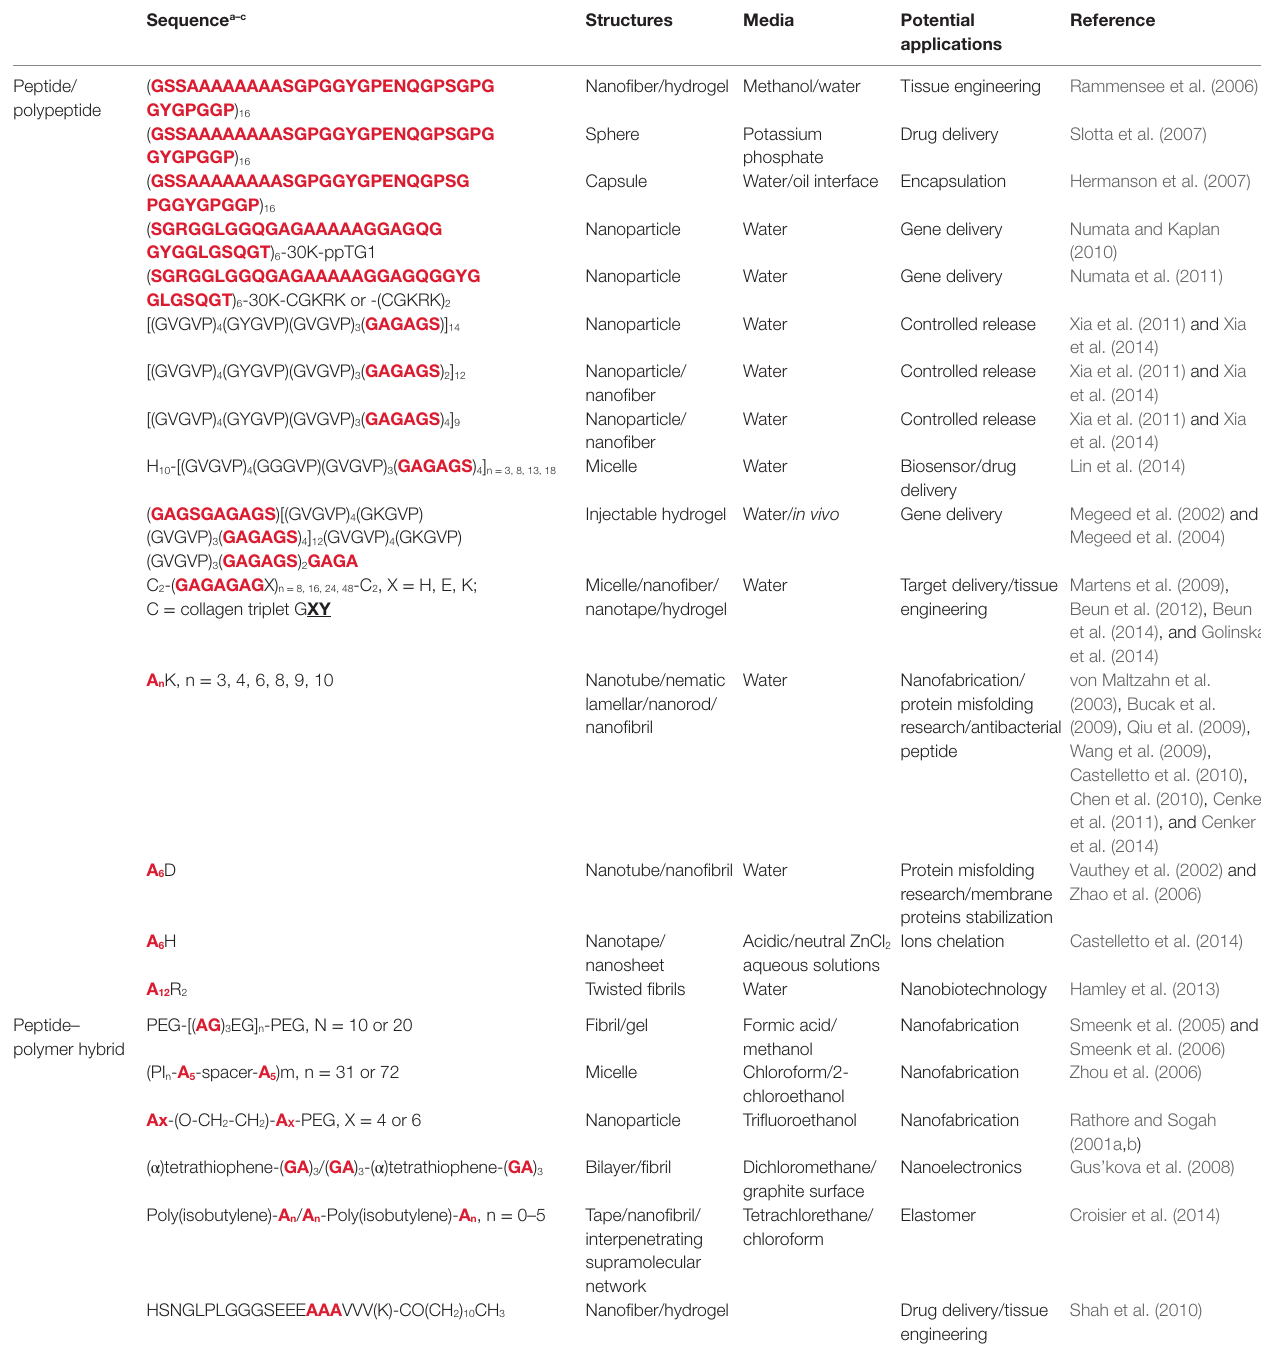
a Red-bolds denote silk protein sequence. b Single amino acid abbreviations used: A, Ala; C, Cys; D, Asp; E, Glu; G, Gly; H, His; K, Lys; L, Leu; M, Met; N, Asn; P, Pro; Q, Gln; R, Arg; S, Ser; and V, Val. c Non-functional amino acid sequence domains at N- and C-terminus are omitted for simplicity. G XY : X and Y positions can be any residue but are frequently occupied by Pro and